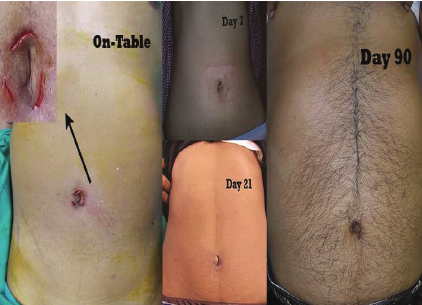
Figure 4: Postoperative scars. Note the undistorted umbilicus with miniscars that are hardly visible. Inset . The close-up view of on-table per-umbilical